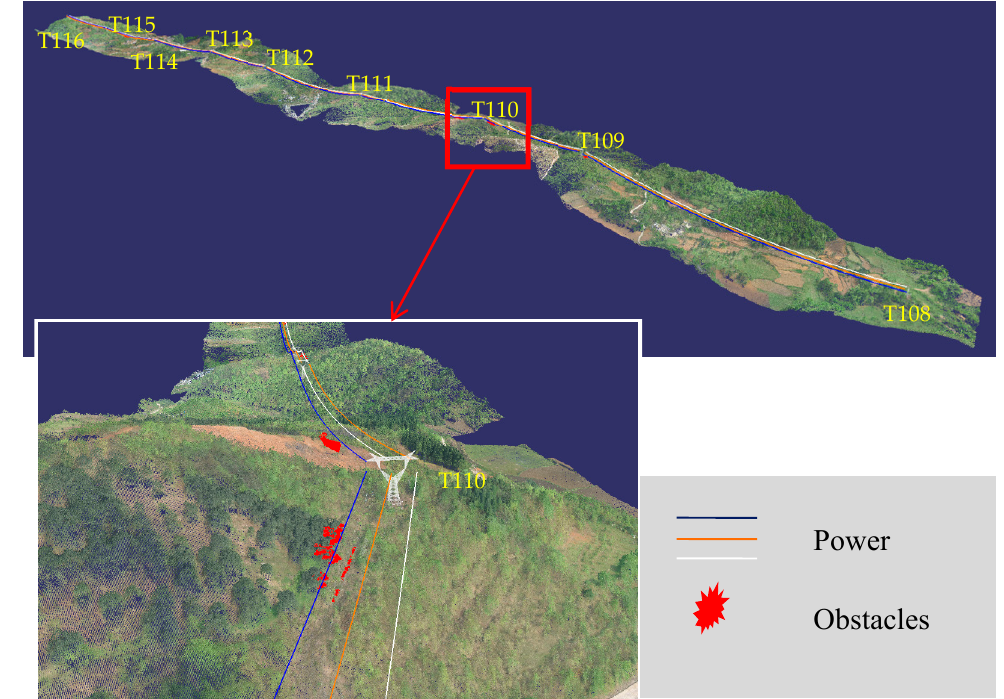
Figure 16. Three-dimensional reconstruction of the power line corridor and the distribution of obstacles.